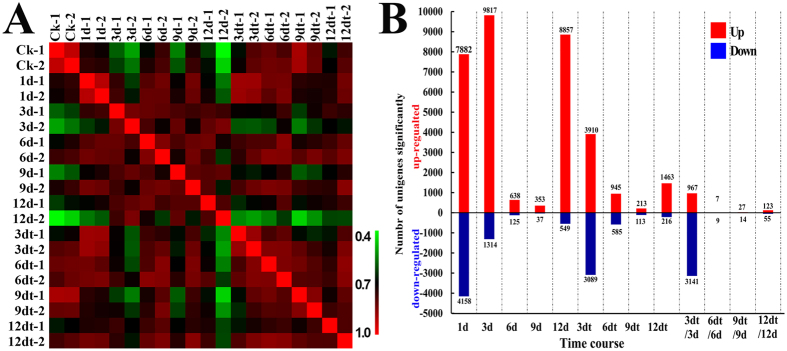
Correlation and profiling of transcriptomic response to ETH using RNA-Seq.(A) Correlation matrix of the whole data set. The analysis was performed by comparing the values of the entire transcriptome (120316 unigenes) in all 22 samples with two biological replicates. Correlation analysis (coefficients R2) was performed using R software. (B) Number of significantly differentially expressed genes after ETH treatment (P < 0.05, FDR < 0.05).